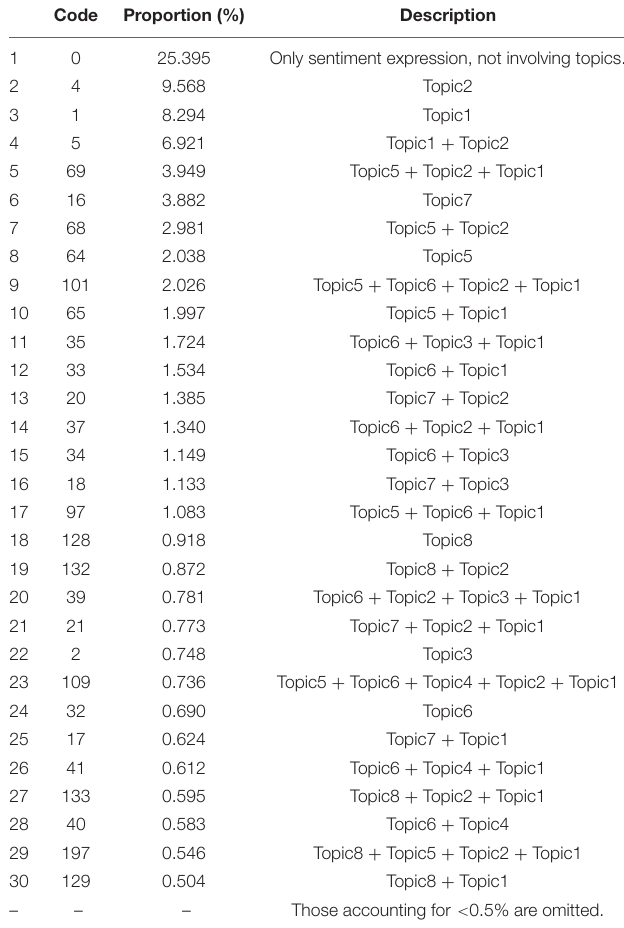
TABLE 5 | Experiment results of multi-label classification model. Code Proportion (%)